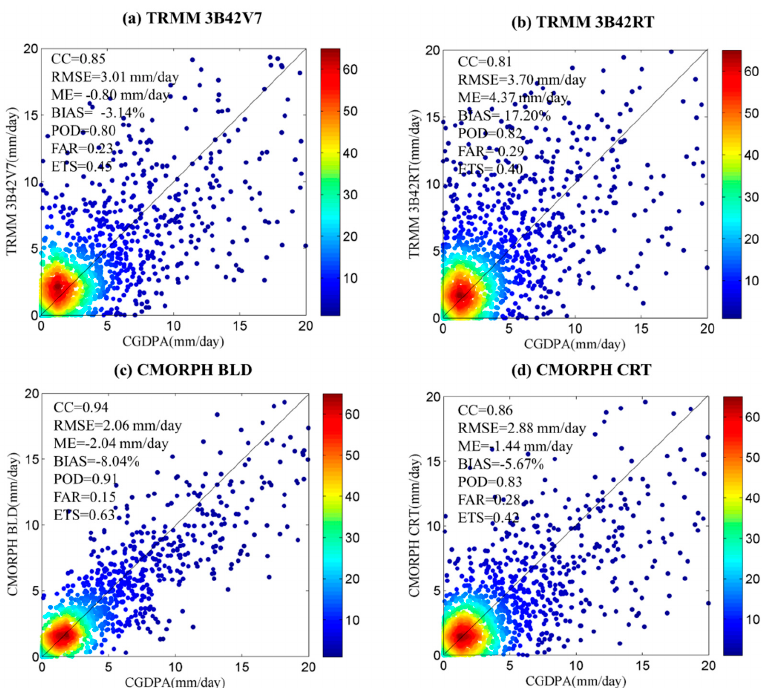
Figure 7. Density-colored scatterplots of basin-averaged precipitation comparison of four products against CGDPA rainfall rate for ( a ) TRMM 3B42V7, ( b ) TRMM 3B42RT, ( c ) CMORPH BLD and ( d ) CMORPH CRT. The color represents the occurrence frequency. The dark solid line denotes 1:1 line.